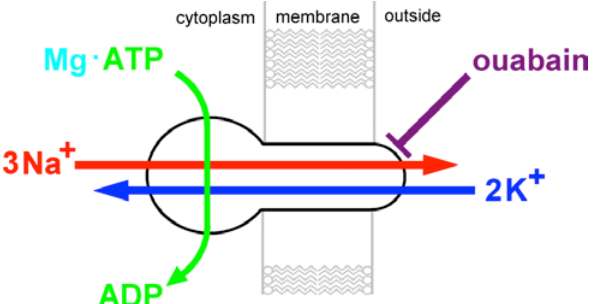
Figure 2. Biochemical characterization of the Na,K-ATPase. The ion pump is an integral membrane protein of animal cell mem- branes with its enzymatic machinery located on the cytoplasmic side. It hydrolyzes one MgATP complex into ADP and inorganic phosphate, P i , and utilizes the released free energy to expel 3 Na + ions from the cytoplasm and to translocate 2 K + ions into the cyto- plasm. Ouabain, a cardiac glycoside, is a specific inhibitor that com- pletely blocks the Na,K-ATPase from the extracellular side of the